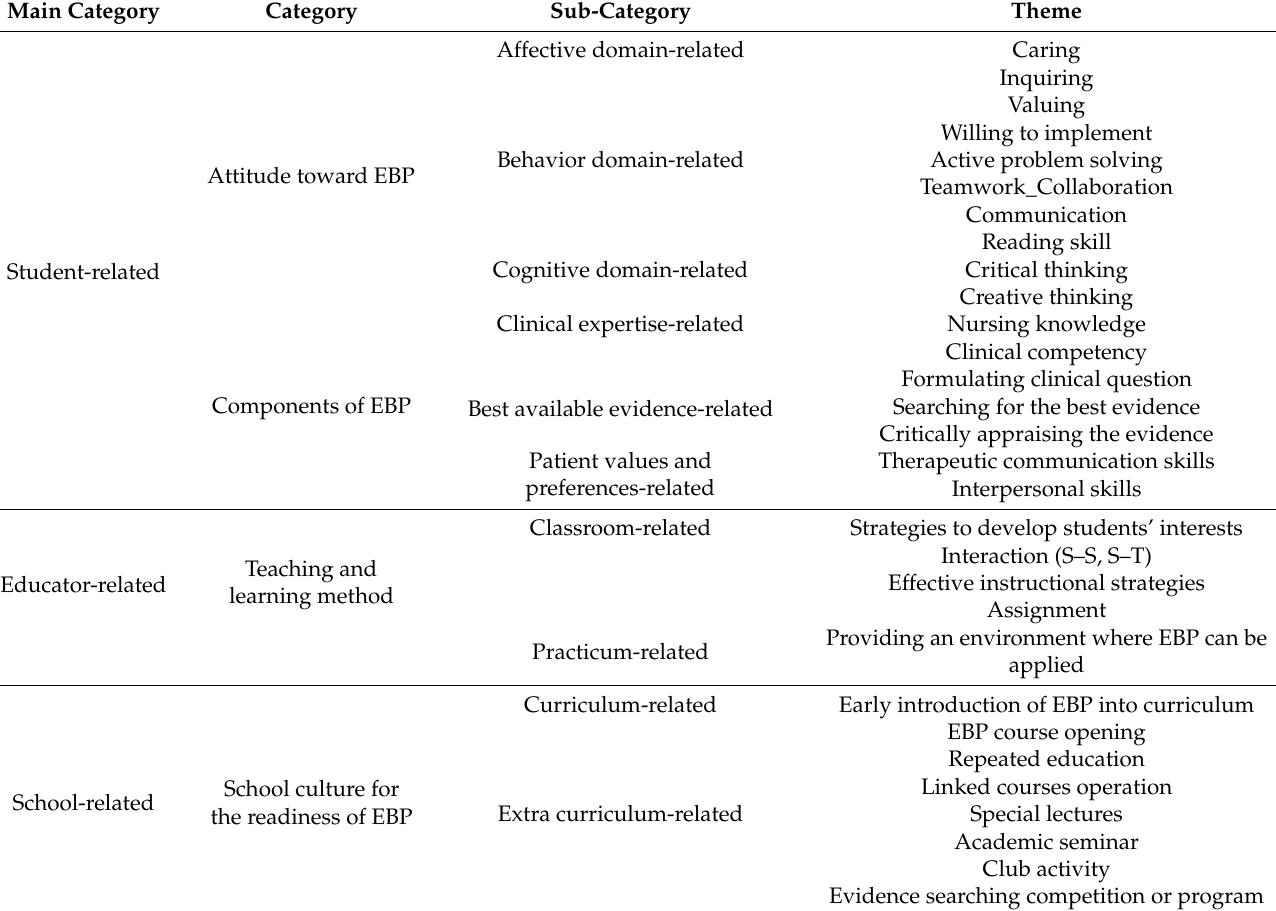
Table 1. Results of qualitative